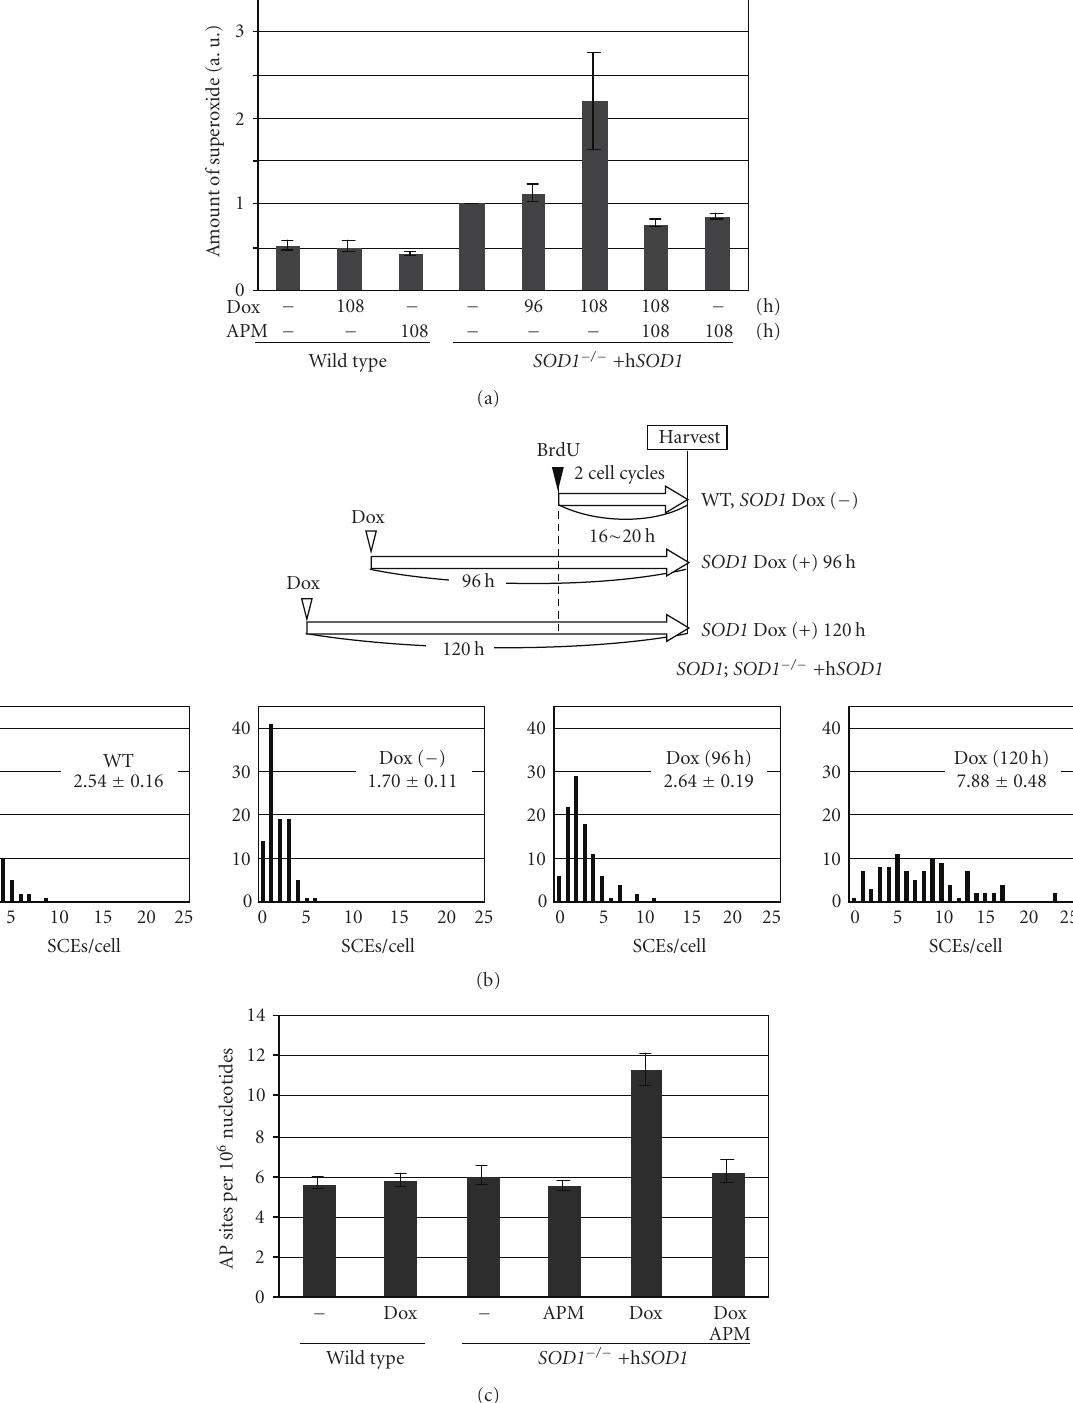
Figure 3: Increases in superoxide, SCE frequency, and AP sites upon depletion of SOD1. (a) Superoxide level. Levels of superoxide were measured with BES-So-AM. The intensity of SOD 1 − / − + h SOD1 cells not treated with Dox was used as the standard (a.u.; arbitrary unit = 1). Error bars indicate standard errors based on three independent experiments. (b) SCE frequency. Schematic representation of cell treatment is depicted in upper panel. Cells were cultured for two cell cycles in a medium containing BrdU. Histograms represent SCEs in wild-type cells and in SOD 1 − / − cells treated with Dox for the indicated timepoints. The mean and standard error are shown in the upper right corner. (c) AP sites. Scanning densitometric analysis of slot blots of endogenous AP sites was performed as described previously in [21]. Some cells were treated with Dox and/or APM for 112 hours. Bars indicate standard